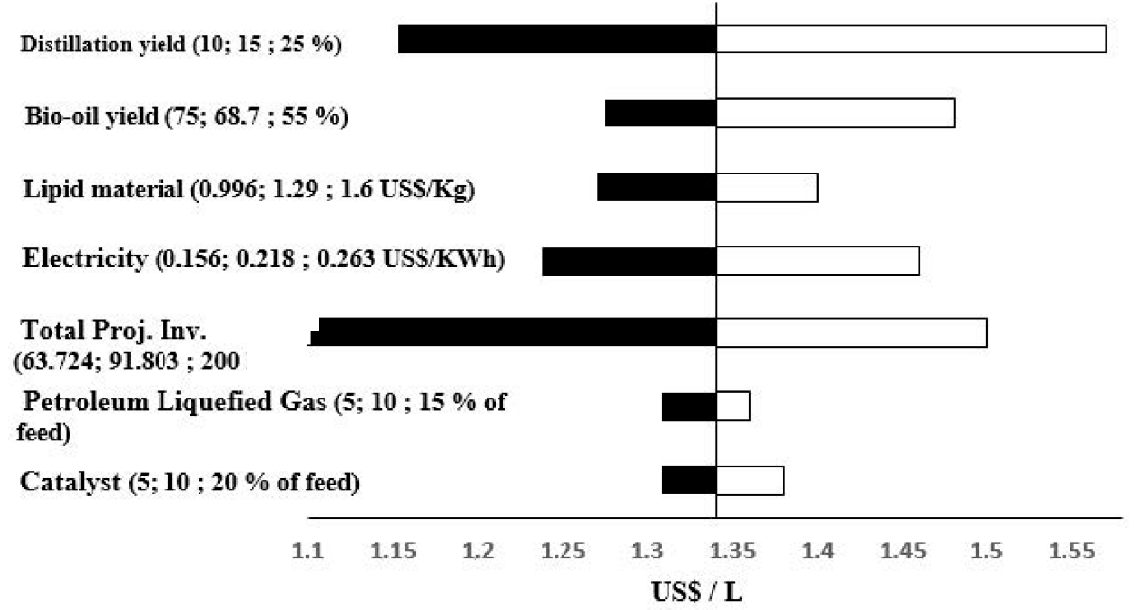
Figure 4. Sensitivity analysis for 450 L/day; to reach the baseline transportation fuel MFSP of 1.34 US$/L, the 10% facility IRR is assumed.